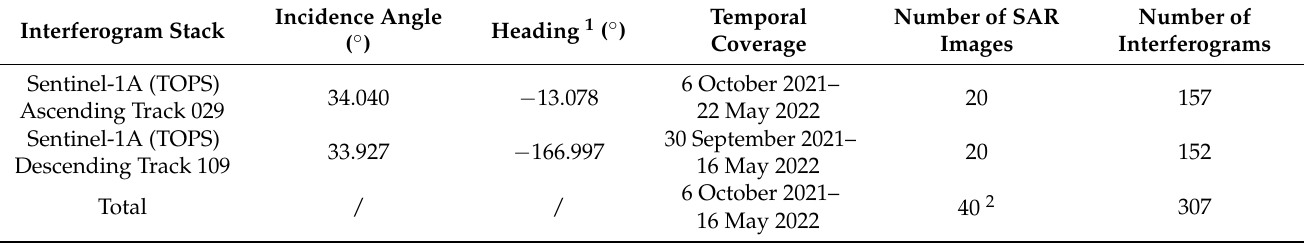
Table 2. SAR parameters used for time-series InSAR